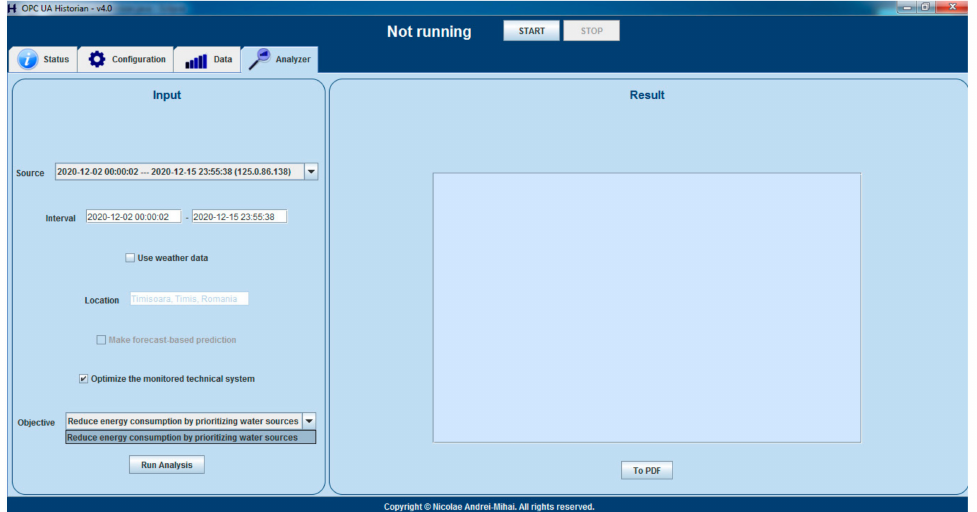
Figure 4. Optimizing objectives choice inside the proactive Historian